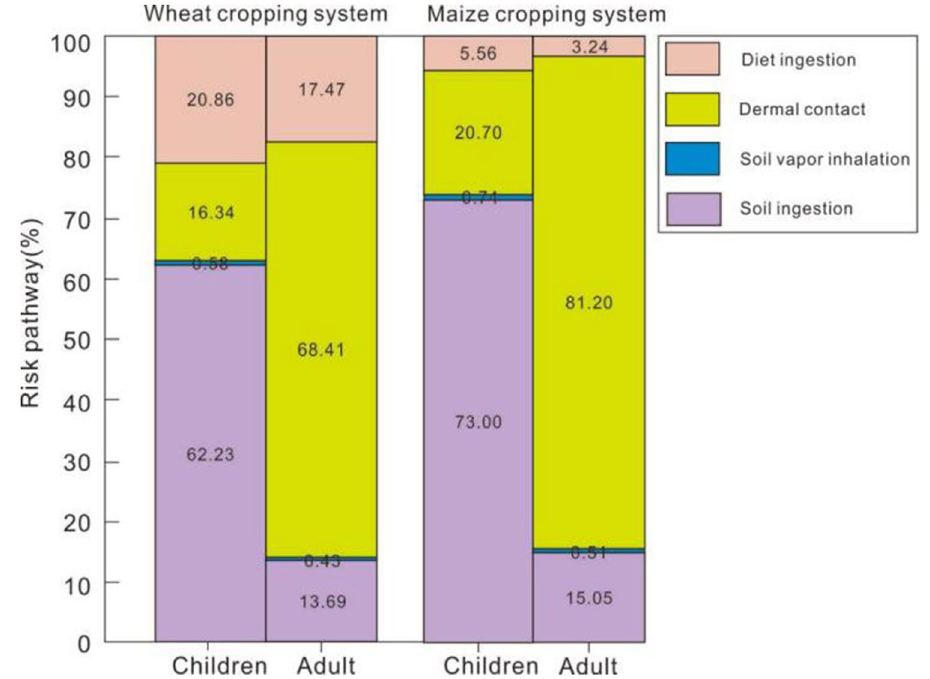
Figure 4. Non-carcinogenic risk exposure pathways under wheat and maize cropping